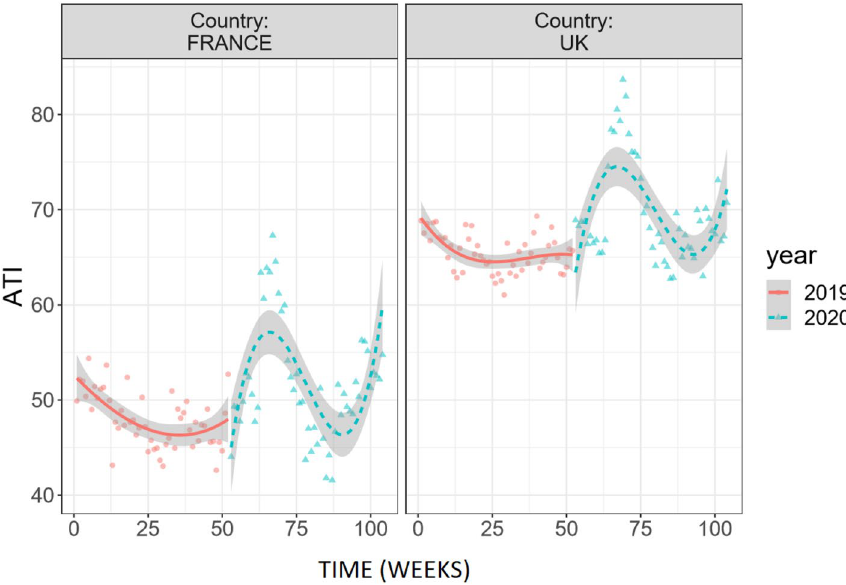
Figure 3. Chronogram for ATI, weekly measures across France and the UK and over the weeks from January 1st of 2019 (1) to December 30th of 2020 (n = 104). Fitted lines represent polynomial for ATI and grey areas represent SEs.